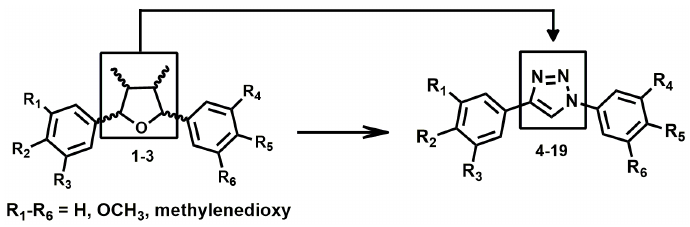
Figure 3. Structure of the neolignans veraguensin 1 , grandisin 2, and machilin G 3 .